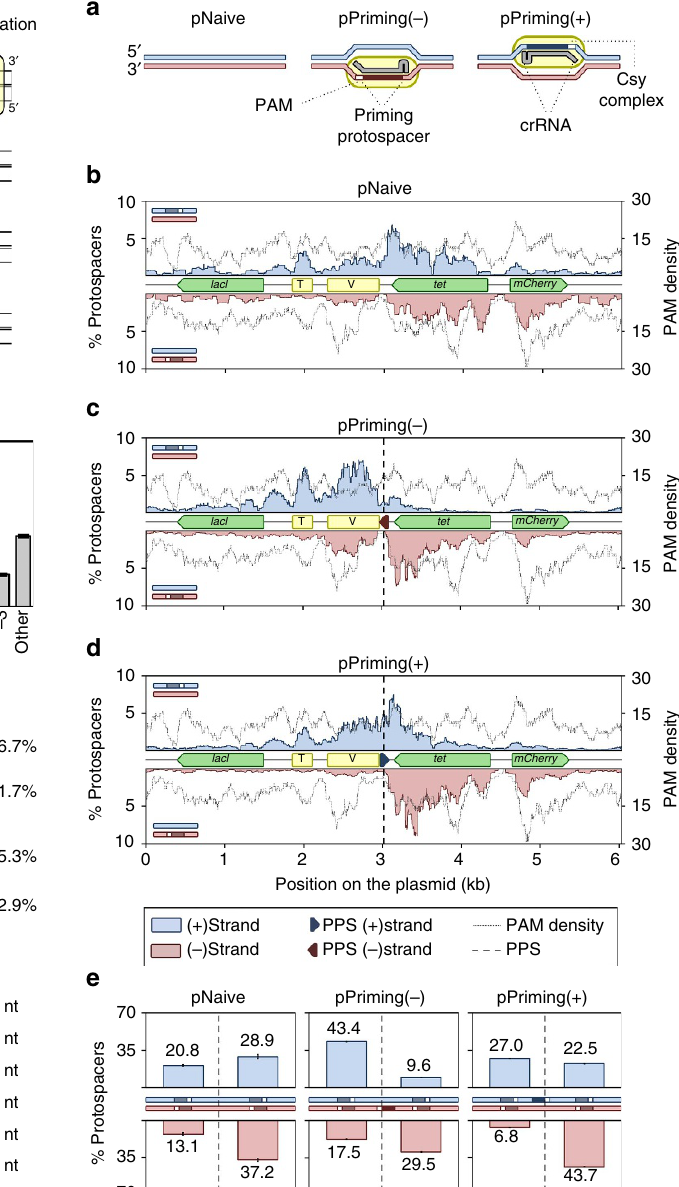
Figure 3 | Link between non-canonical PAMs due to slipping and spacer lengths. ( a ) Sequence context and schematic representation of slipping, which results in capture of spacers that map to non-canonical PAMs. ‘Spacer*’ denotes the strand with the sequence identical to the spacer in the CRISPR array. ( b ) Frequency of slipping events observed in each dataset. ‘Other’ indicates that the 3 0 end of the PS was 4 3nt from the nearest GG. ( c ) Slipping category assigned to spacers of non-canonical lengths, and schematic view of the mechanistic implications. ( d ) The lengths of spacers resulting from each slipping category. For the analyses in c , d only protospacers mapping to the plasmid that could not have resulted from flipping are presented. Error bars represent the s.e. of the mean.